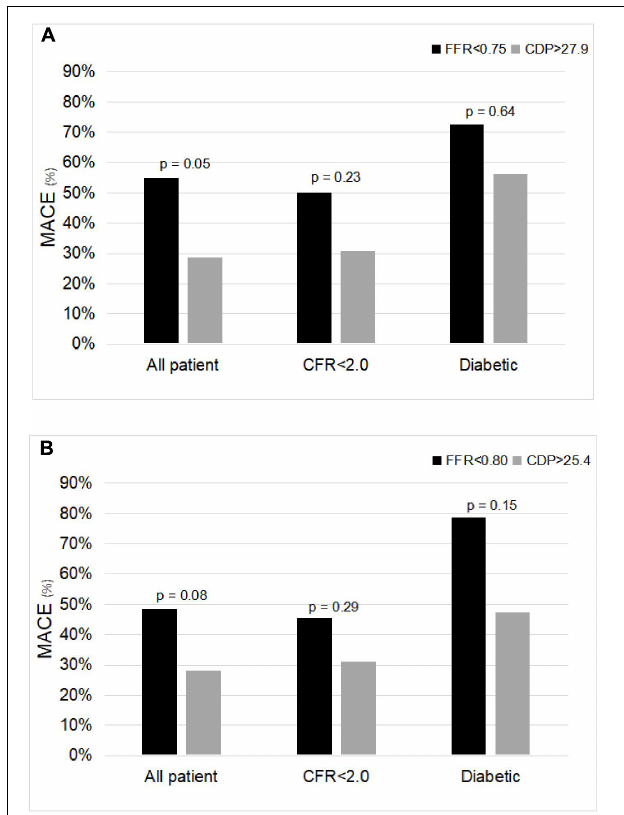
FIGURE 2 | Comparison of %MACE between (A) FFR < 0.75 and CDP > 27.9 groups and (B) FFR < 0.80 and CDP > 25.4 groups for the all-patient group and for the microvascular disease sub-groups: CFR < 2.0 and diabetic. The p -values are provided for the chi-square test. MACE, major adverse cardiac events; FFR, fractional flow reserve; CDP, pressure drop coefficient.